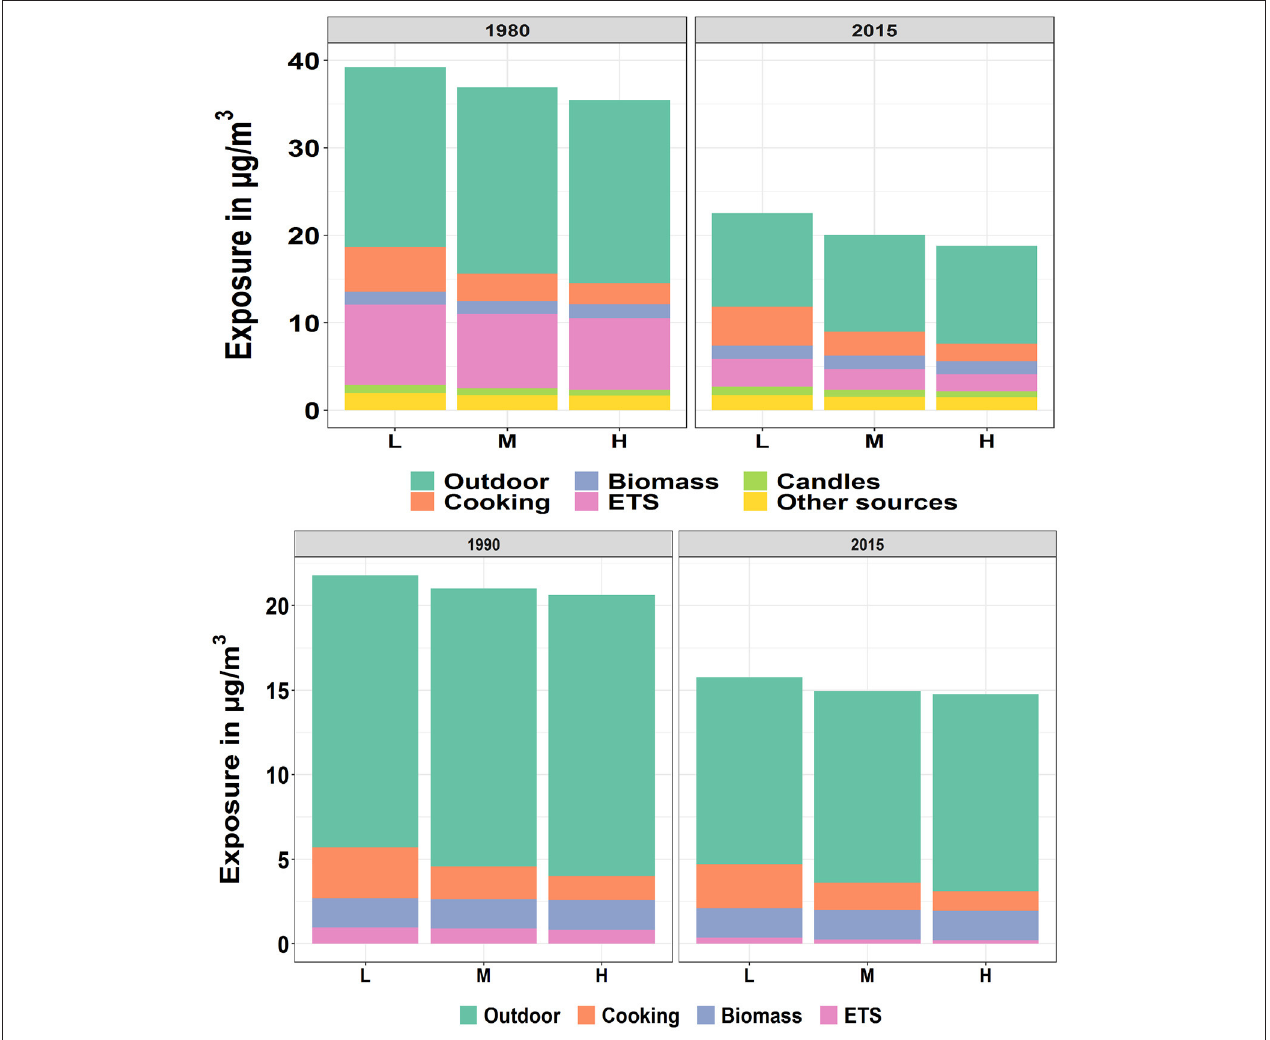
FIGURE 8 | Population-weighted arithmetic mean PM2.5 (upper) and NO 2 (lower) exposure by source and income level for European countries in 1980/1990 and 2015. The “L”, “M” and “H” represent the “Low”, “Median”, and “High” level of income, respectively.